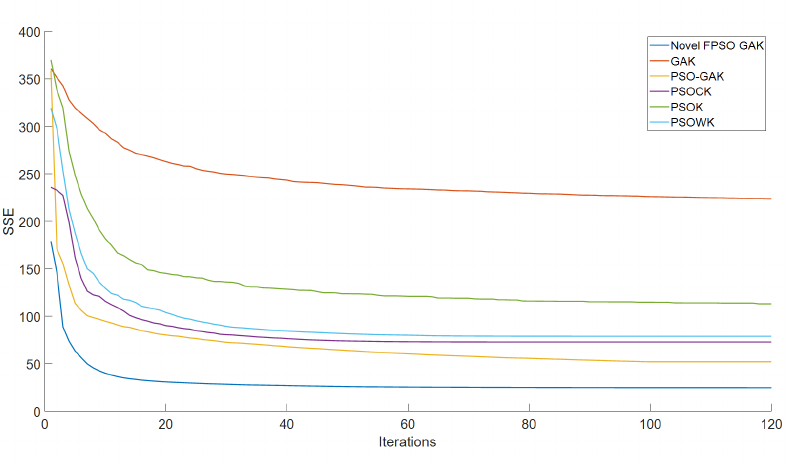
Figure 4. The SSE convergence curve for the searching optimal initial clustering centers stage of taxi GPS dataset from Aracaju